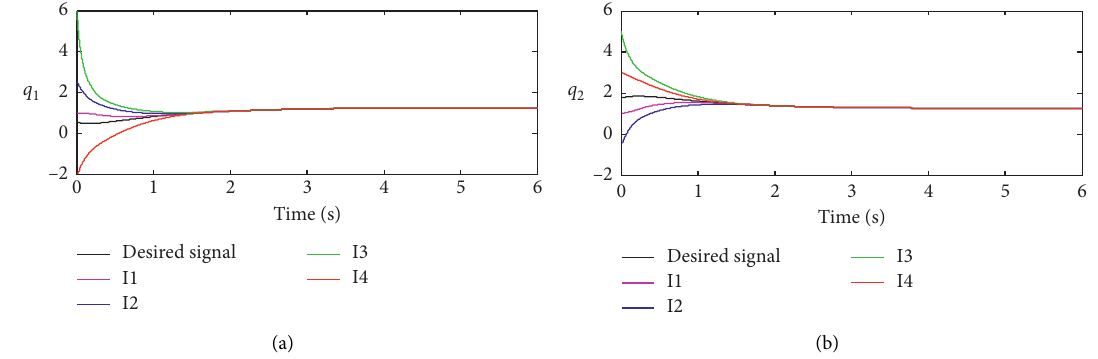
Figure 2: Position tracking performance with different initial states.